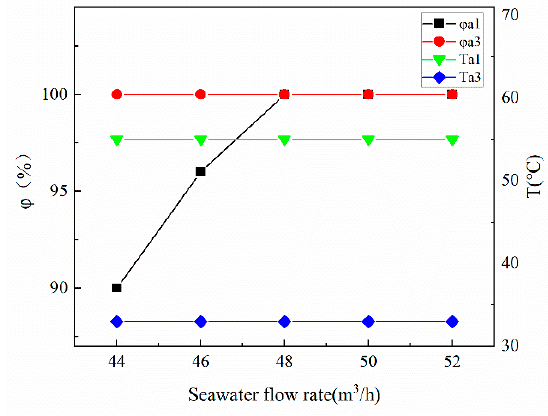
ff ect of seawater flow rate on air Figure 9. Effect of seawater flow rate on air humidity. Figure 9. E Figure 9. Effect of seawater flow rate on air humidity.